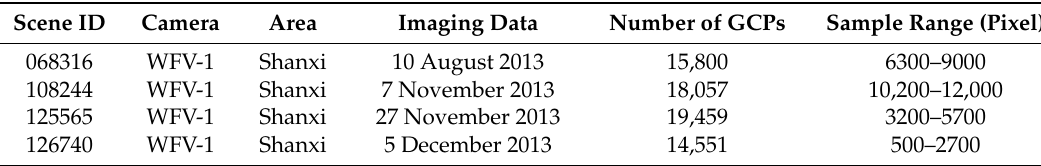
Table 2. Details of the GF-1 WFV-1 calibration images.